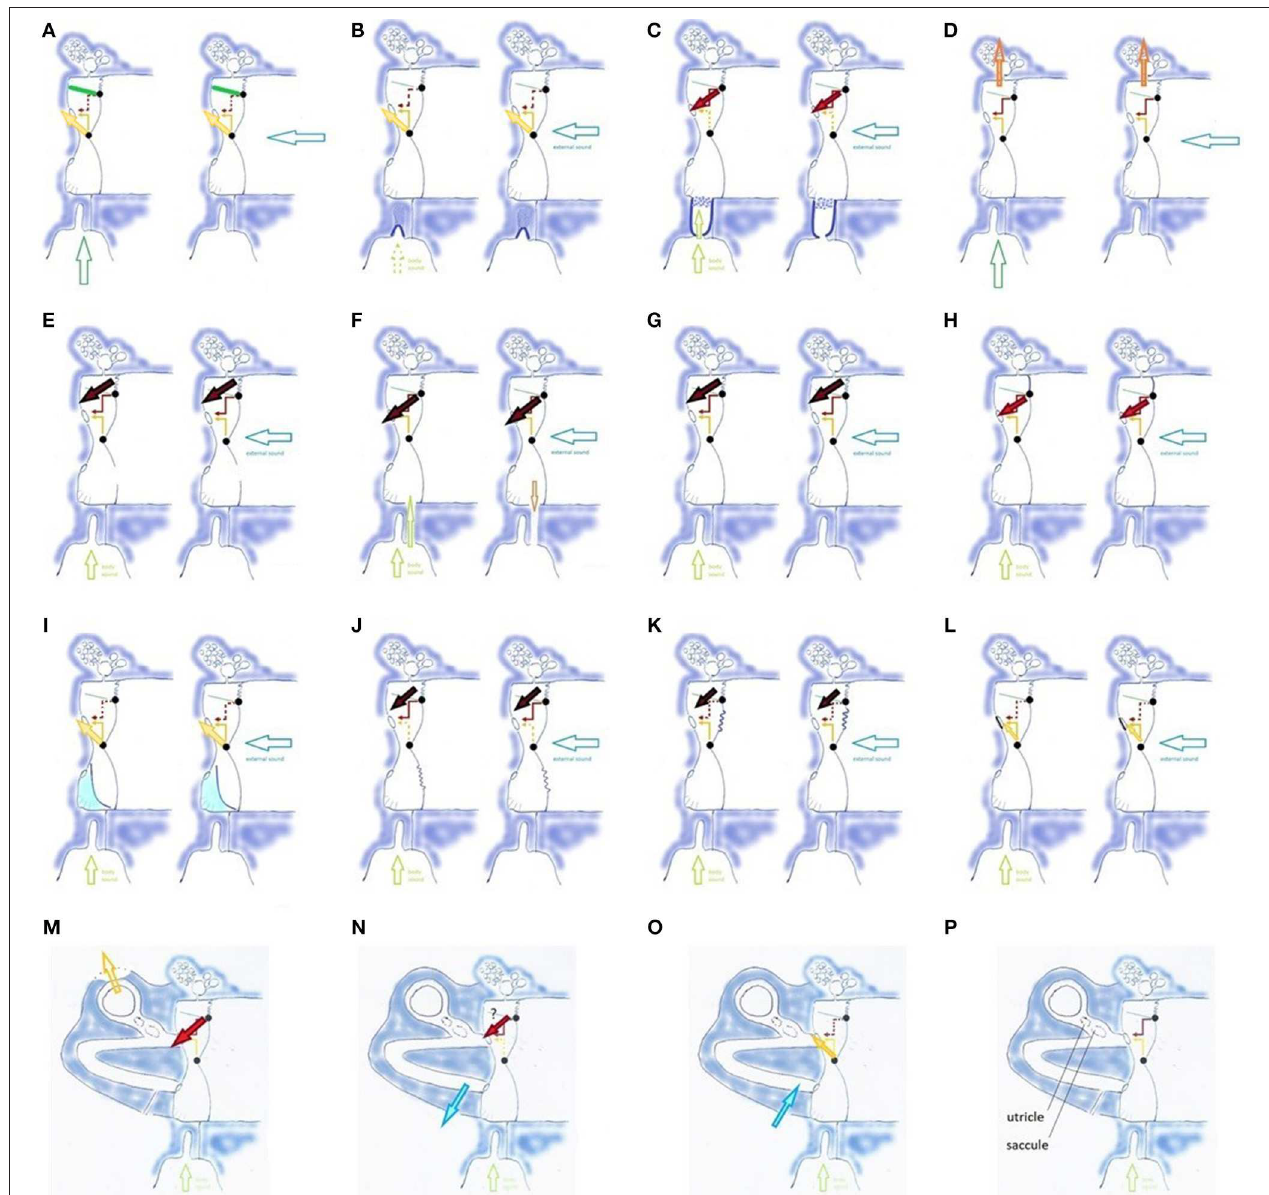
FIGURE 6 | Influences on TMRF (physiologic mechanisms (A–D,G,H) , pathologic mechanisms related to middle ear (E,F,I–L) , and inner ear (M–P) ; (A) TT contraction (TT: green line) shifts TMRF upward, decreased transmission of lower frequencies (dotted red arrow) and increased transmission of mid-frequencies (yellow arrow). Similar effect for pharyngeal (left, vertical hollow arrow) and external sounds (right, horizontal hollow arrow); (B) PR/ET closure shifts TMRF upward for pharyngeal and external sounds and decreases awareness of pharyngeal sounds (dotted vertical hollow arrow); (C) opening the PR/ET complex shifts TMRF downward for pharyngeal and external sounds (dotted yellow arrow, red arrow) and increases awareness of pharyngeal sounds; (D) filtering effect of antrum, mastoid and temporal apex cells. Specific frequency bands may be involved, depending on the vascular filling of these cells and gas composition in the mastoid. The effect may be different for pharyngeal and external sounds; (E) loss of the middle ear air cushion (here after paracentesis) causes a sudden and uncontrolled increase of the (0,1) mode and decrease of the preferred modes. A reactive TT contraction and PR/ET closure may shift TMRF upward (not illustrated). The large black arrow indicates the increase in very low frequency transmission, corresponding with the missing fundamental and the (0,1) mode; (F) loss of the air cushion in PET (extra vertical hollow arrow): increased pharyngeal sound transmission causes autophony; middle ear air cushion loss and its effect on the (0,1) mode causes dull hearing; (G) Pars flaccida loose: decrease of air cushion effect with downward TMRF shift; (H) Pars flaccida tense: increased air cushion effect, TMRF shifts upward from the very low to the low frequencies. The stiff pars flaccida acts like an extension of the upper hemitympanum, which causes an increased transmission for low frequency sounds (red arrow). (I) Partial filling of the tympanic cavity, causing TMRF upward shift. Compensatory PR/ET opening (not illustrated) may increase pharyngeal sound transmission and cause autophony; in more complex situations the fluid may impact against the TM or cover the RW; (J) Flaccid area in lower hemitympanum causes a